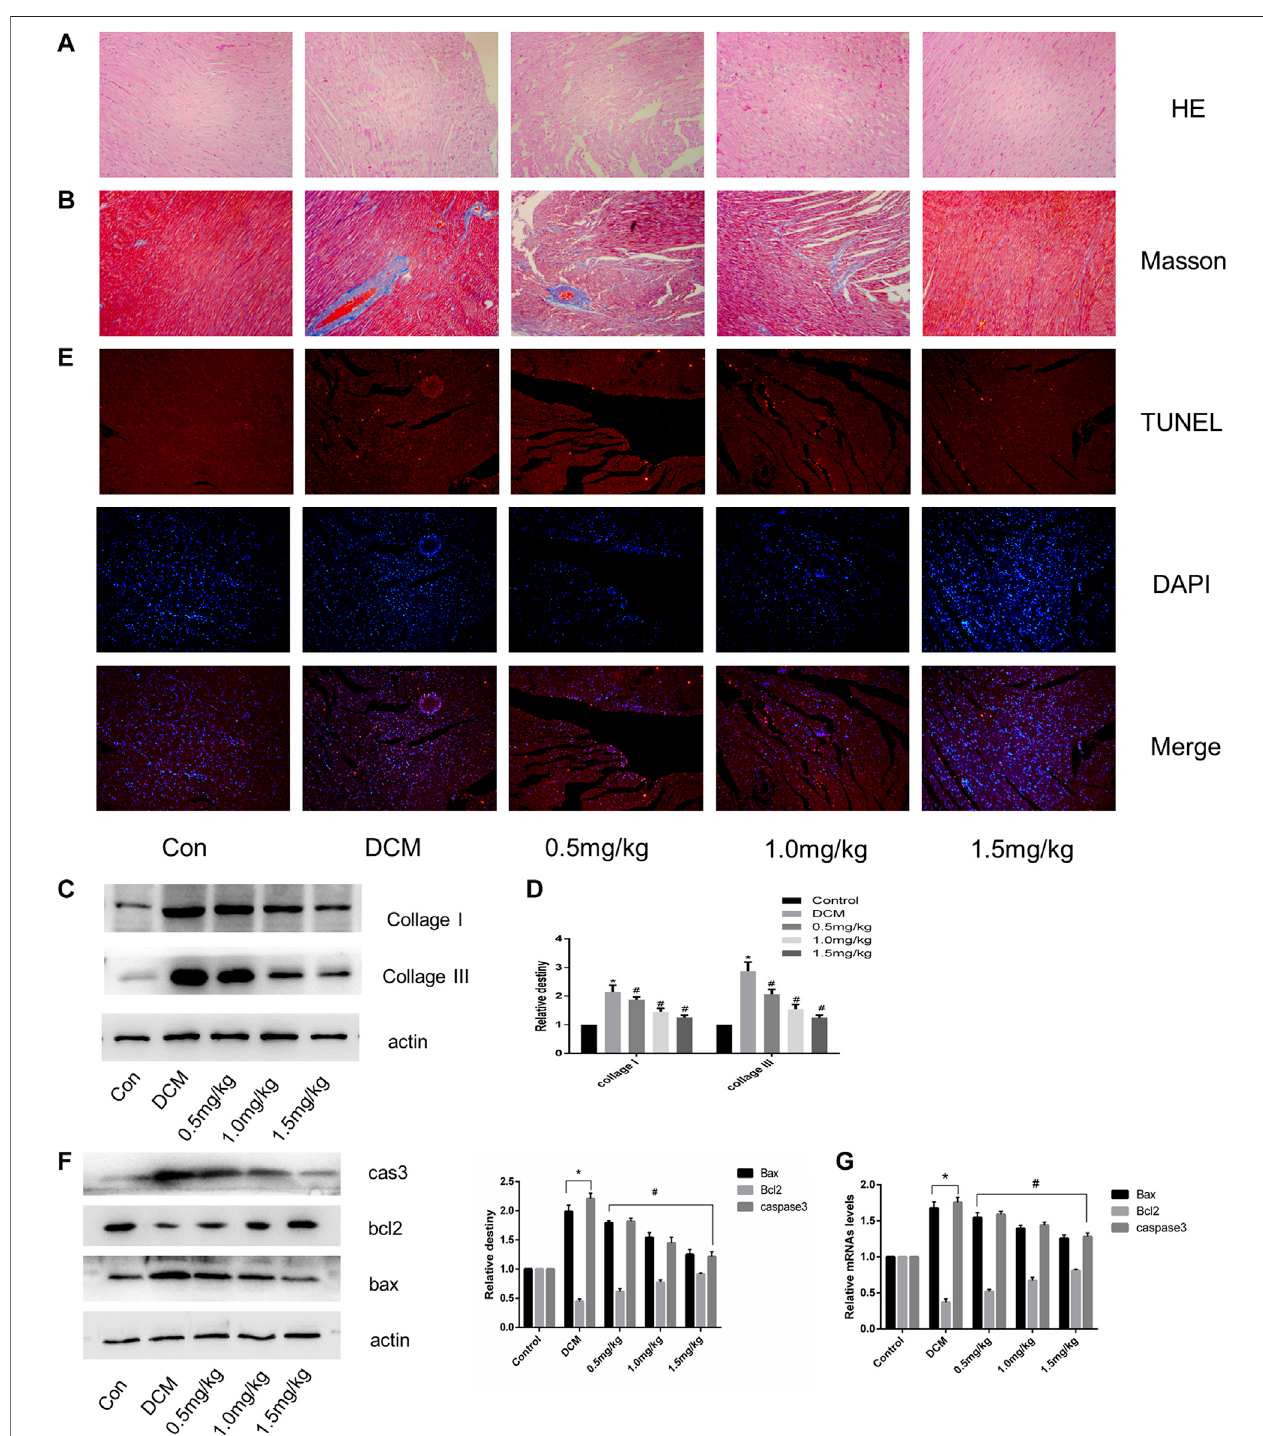
FIGURE 4 | SGLT1 inhibition relieved myocardial fi brosis and apoptosis in diabetic rat hearts (n (cid:1) 10). (A – B) HE and Masson ’ s Trichrome staining of myocardial tissue. (C – D) RelativeproteinlevelsofcollagenIandcollagenIII. (E) ApoptoticrateofcardiomyocytesmeasuredbyTUNELstaining. (F) Bax,bcl2,andcaspase-3protein expression in rats. (G) RT-PCR analysis of bax, bcl2, and caspase-3 in tissues. * p < 0.05 control; # p < 0.05 vs. DCM. Experiments were performed in triplicate.